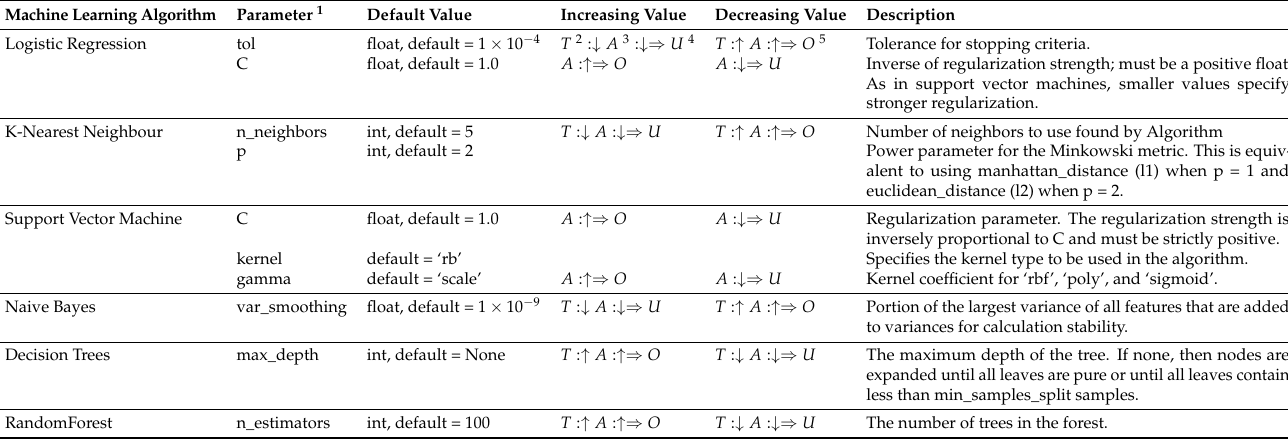
Table 3. Common parameters of selected